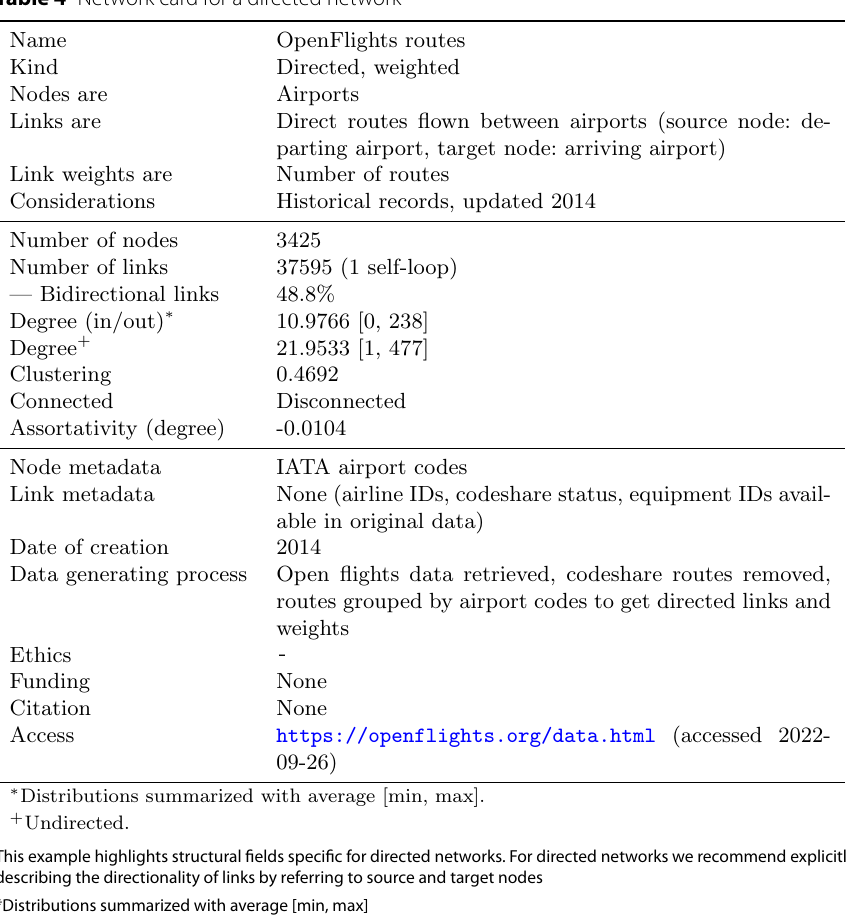
Table 4 Network card for a directed